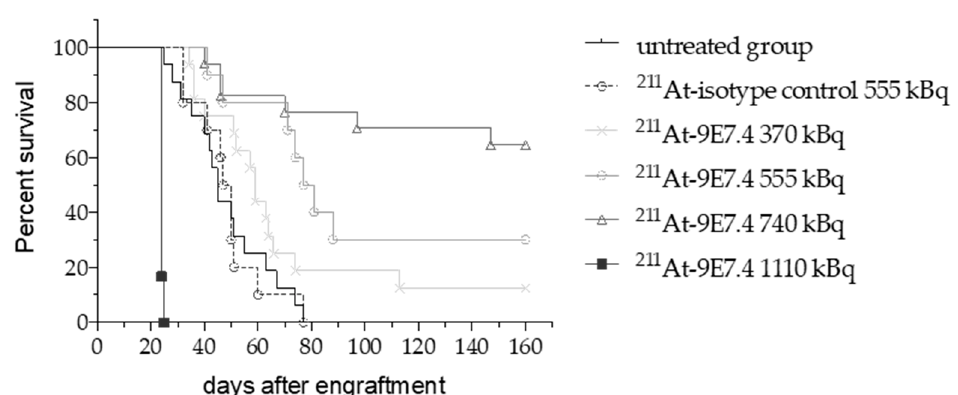
Figure 3. Kaplan–Meier survival curves of TAT (Targeted-Alpha-Therapy) in a disseminated MM mouse model. C57BL/KaLwRij mice received 10 6 5T33 MM cells followed 10 days later by injection of